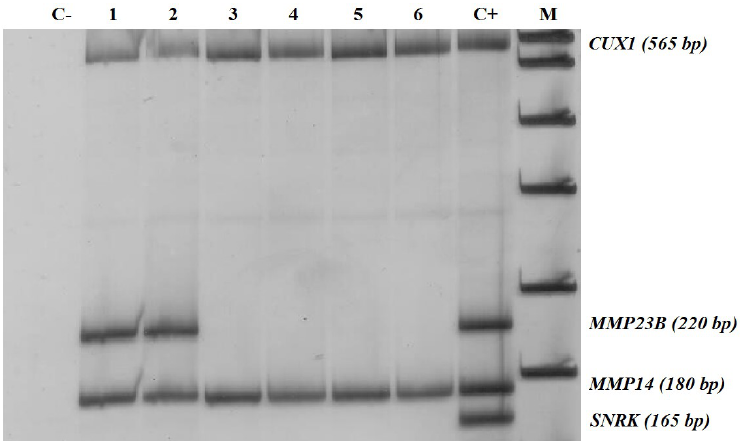
Figure 1. MMP14 and MMP23B simultaneous analysis by methylation-sensitive restriction enzyme digestion PCR (MSRE-PCR). M, DNA ladder pUC19/HpaII; K+, MSRE-PCR products obtained with digestion PCR (MSRE-PCR). M, DNA ladder pUC19 / HpaII; K + , MSRE-PCR products obtained